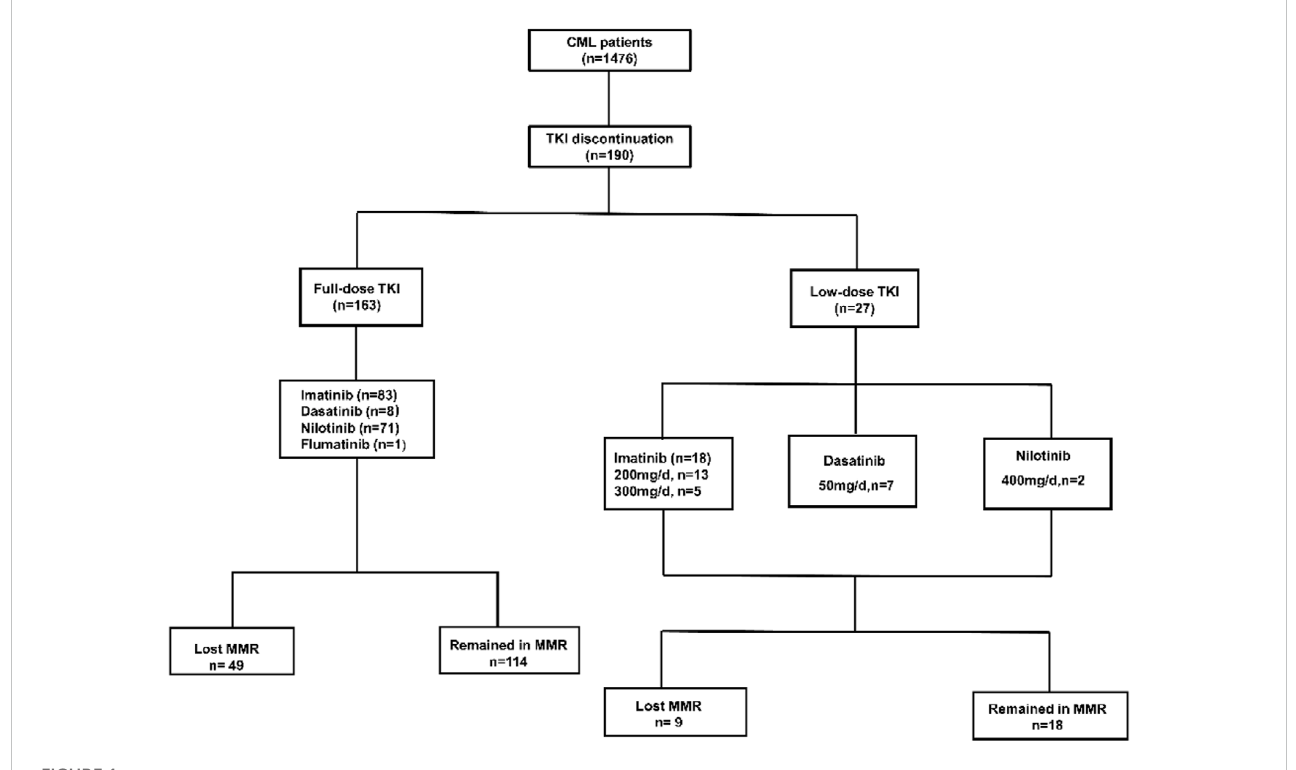
FIGURE 1 Study population fl owchart. TKI, tyrosine kinase